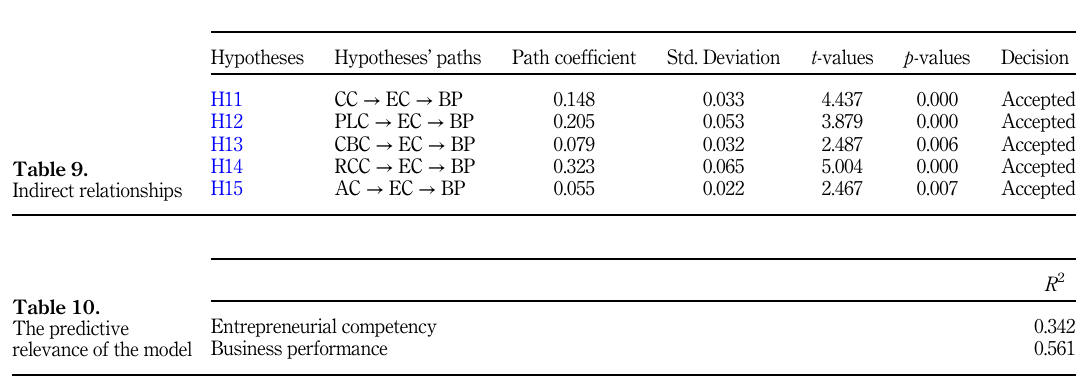
Figure 3. Moderating effect of differentiation strategy